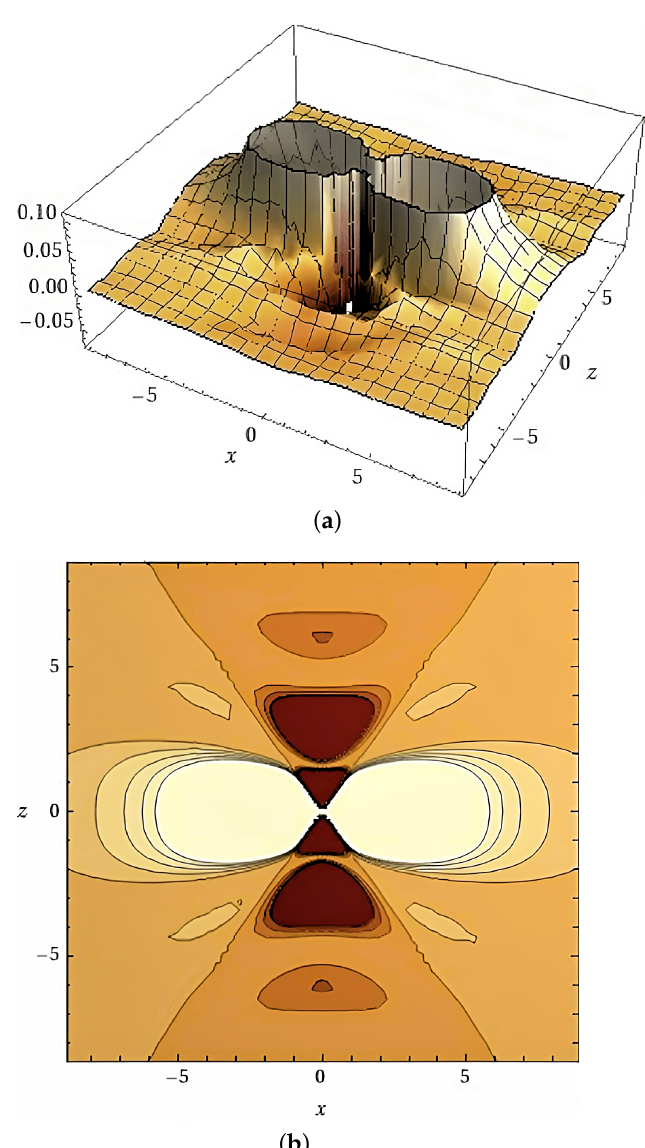
Figure 1. ( a ) 2D plot of the EM intensity distribution (in a.u.) below and above the device surface, ω / ν em = 3.1; ( b ) contour plot of the EM intensity distribution at y = 0. In stealth technology, we also may use a programmable plasmonic circuit, as was proposed in Ref. [46], using a transparent patterned zinc oxide gate to provide full control of plasmons in graphene. These techniques may assist in better design stealth technology [47], and Figure 3 exemplifies the concept. As wide spectrum surveillance (wide bandwidth capability) is needed because the frequency of the enemy radar is not known beforehand, the parameter ν em may be adjusted to lock with the enemy frequency radar ω